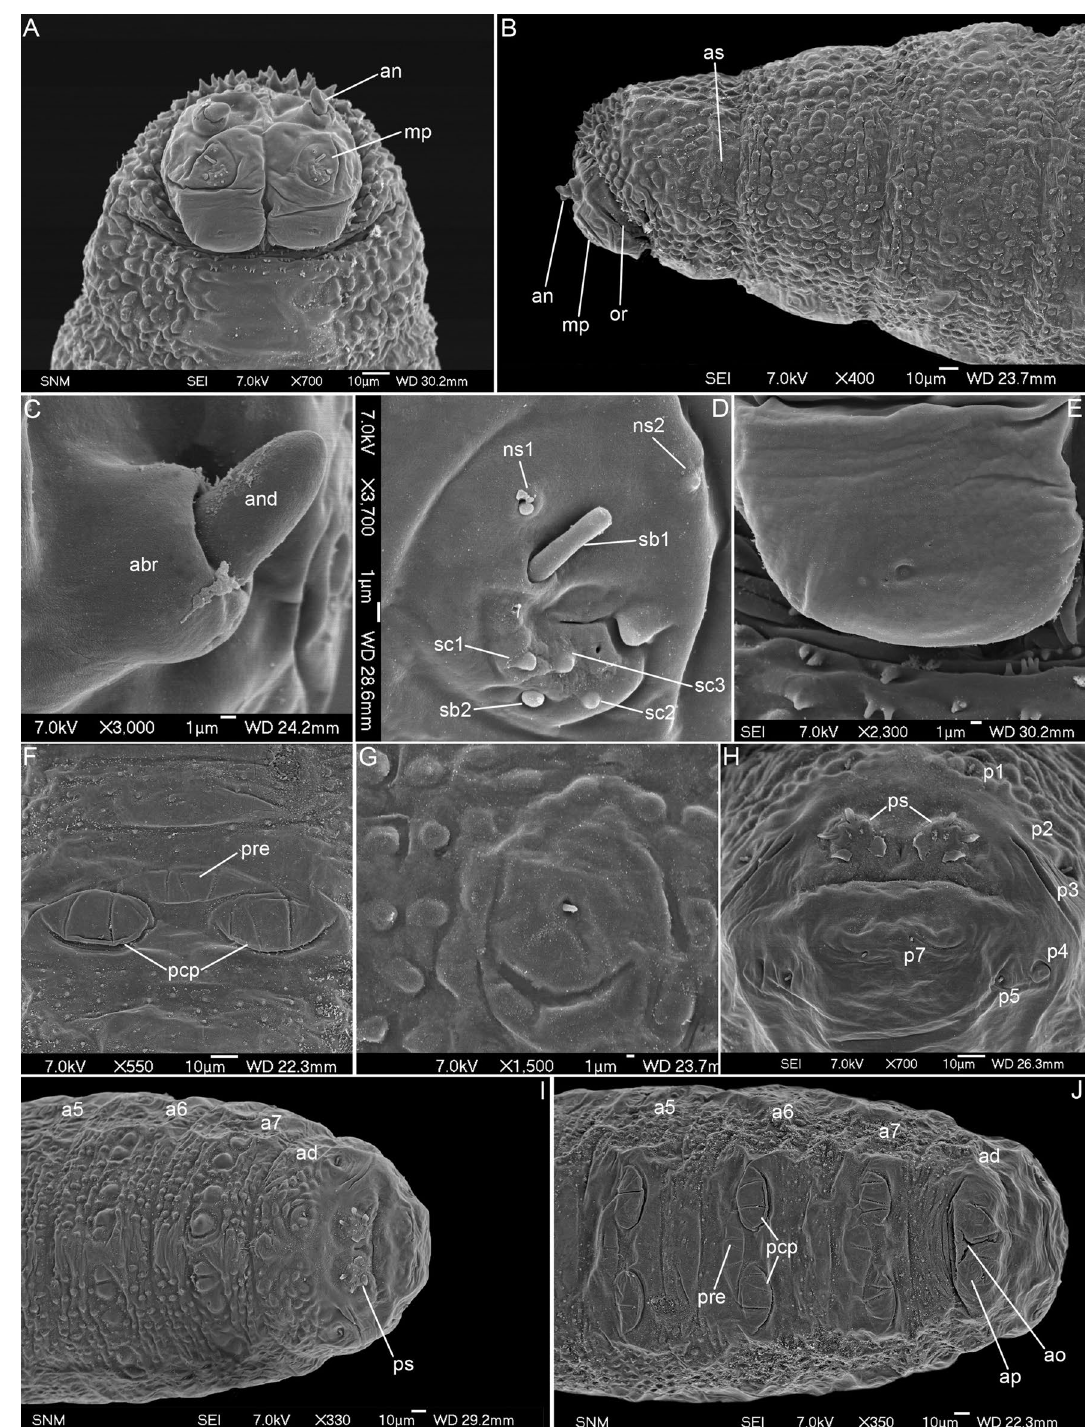
Figure 2. First instar larva of Amobia auriceps . ( A ) Anterior end, ventral view. ( B ) Anterior end, lateral view. ( C ) Antennal complex. ( D ) Maxillary palpus. ( E ) Ventral organ. ( F ) Fifth abdominal segment, ventral view. ( G ) First abdominal segment, lateral papilla. ( H ) Anal division, spiracular field. ( I ) Posterior end, dorsal view. ( J ) Posterior end, ventral view. a5–a7, abdominal segments a5–a7; abr, antennal basal ring; an, antennal complex; ad, anal division; and, antennal dome; ao, anal opening; ap, anal papilla; as, anterior spiracle; mp, maxillary palpus; ns1, first additional sensillum coeloconicum; ns2, second additional sensillum coeloconicum; or, oral ridges; p1–p7, papillae around spiracular field; pcp, post-crevice protuberance; pre, pre-crevice protuberance, ps, posterior spiracle; sb1–3, sensilla basiconica 1–3; sc1–3, sensilla coeloconica